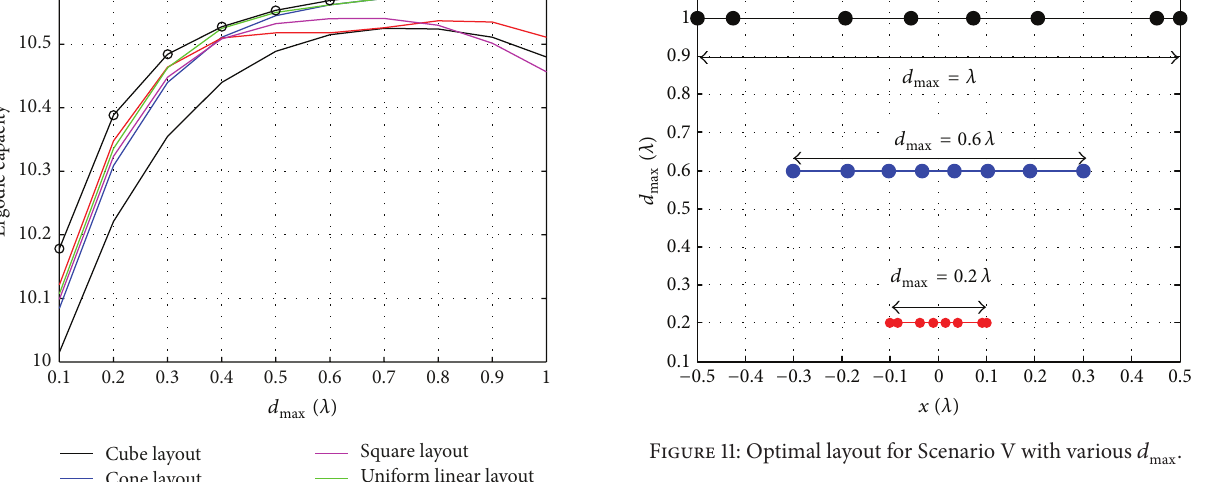
or black denote, respectively, the optimal antenna locations for different 𝑑 max constraints. In case that 𝑑 max = 0.2𝜆 and = 𝜆 , the antennas are almost uniformly distributed on a 𝑑 max circle while in the case of 𝑑 max = 0.6𝜆 , one antenna is placed at the center of the circle and the rests are nonuniformly distributed on the circle.